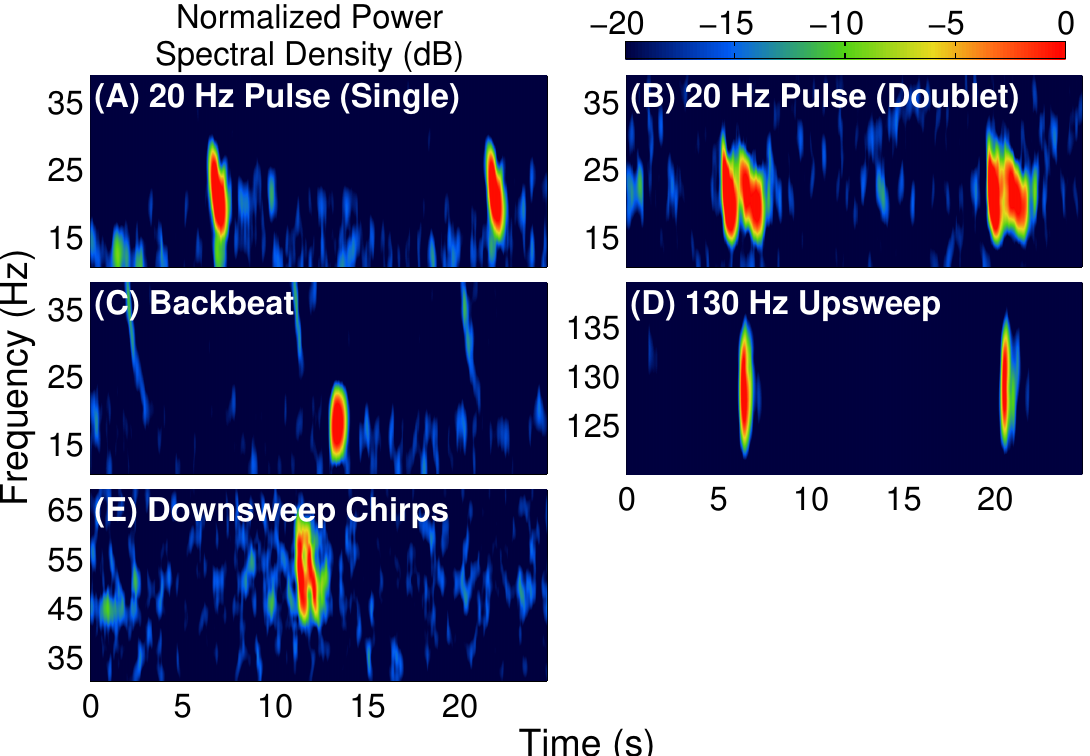
Figure 1. Spectrograms for the fin whale ( A ) 20 Hz pulse (single), ( B ) 20 Hz pulse (doublet), ( C ) backbeat, ( D ) 130 Hz upsweep, and ( E ) 30–100 Hz downsweep chirp, observed during NorEx14 using a coherent hydrophone array